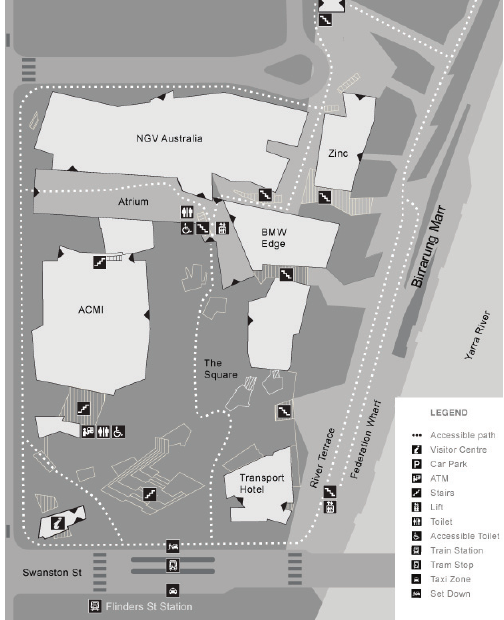
Figure 1: Federation Square (map from fedsquare.com , modi fi